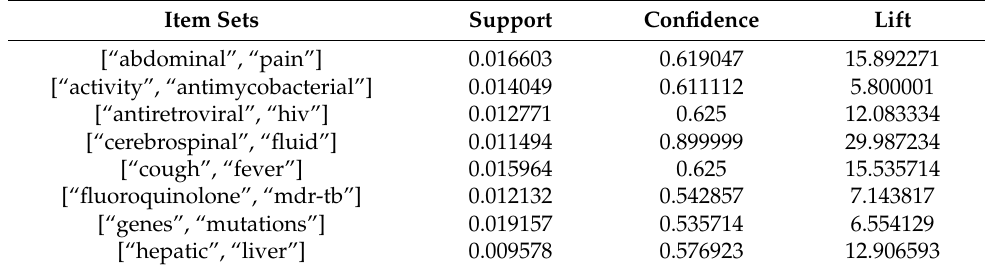
Table 4. Sample item sets of pyrazinamide